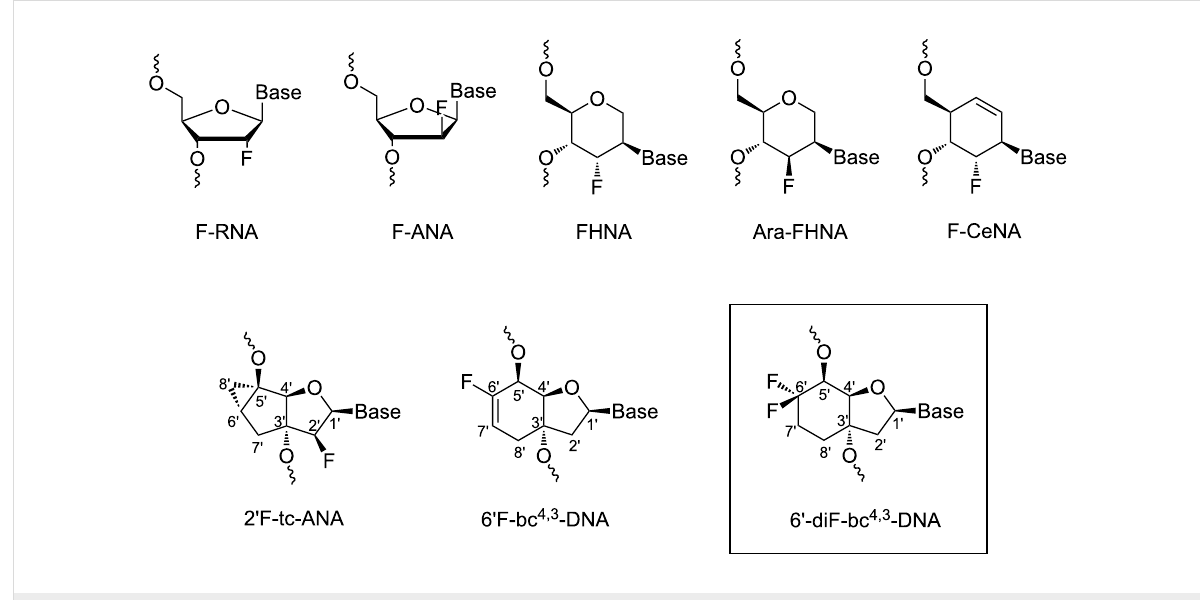
Figure 1: Chemical structure of selected fluorine-modified nucleic